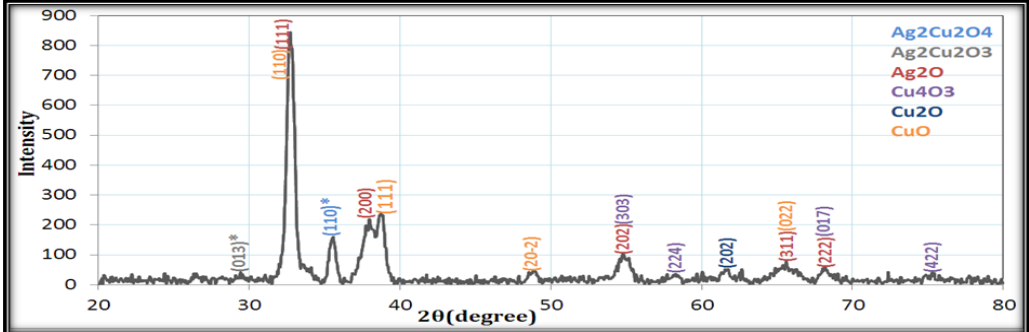
Fig.2: The X-ray diffraction pattern of Ag